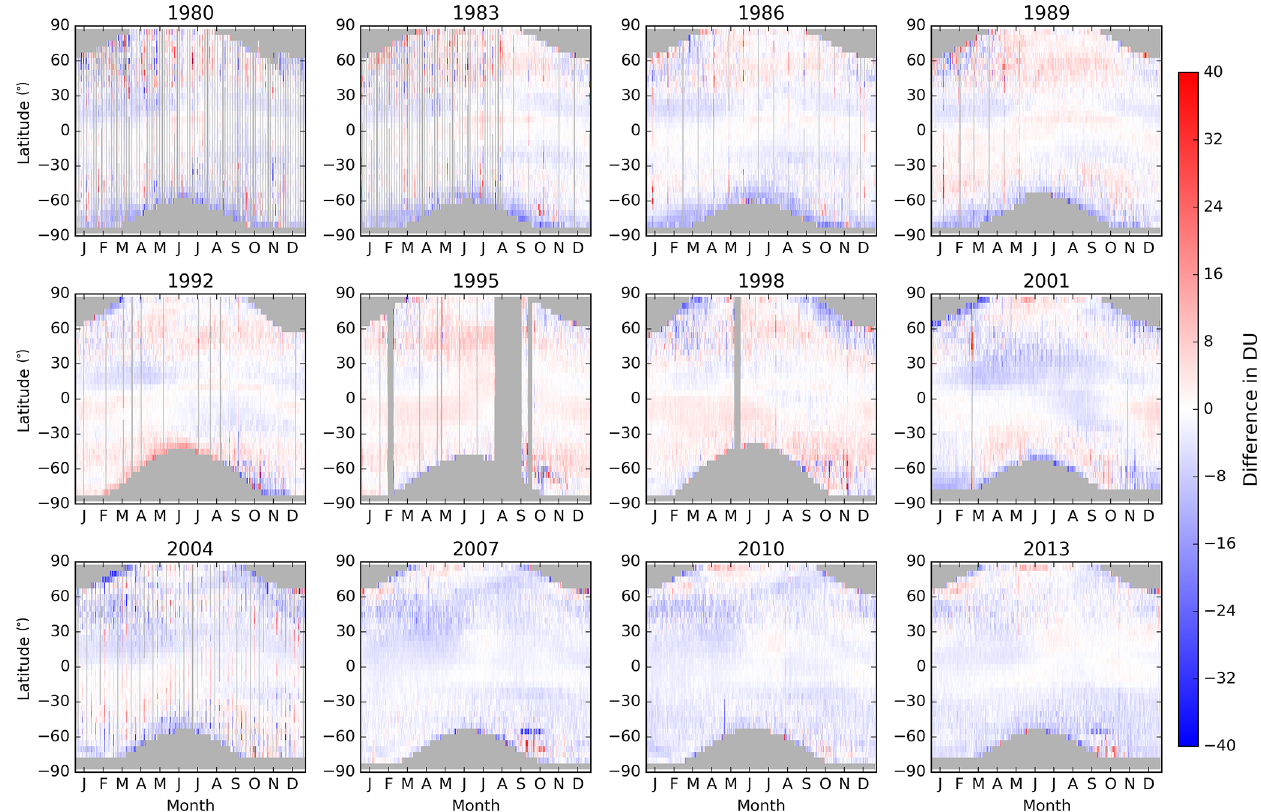
Figure 10. Daily differences between 5 ◦ zonal means calculated from the NIWA-BS TCO database and the NOAA SBUV V8.6 database for the same years as in Fig.